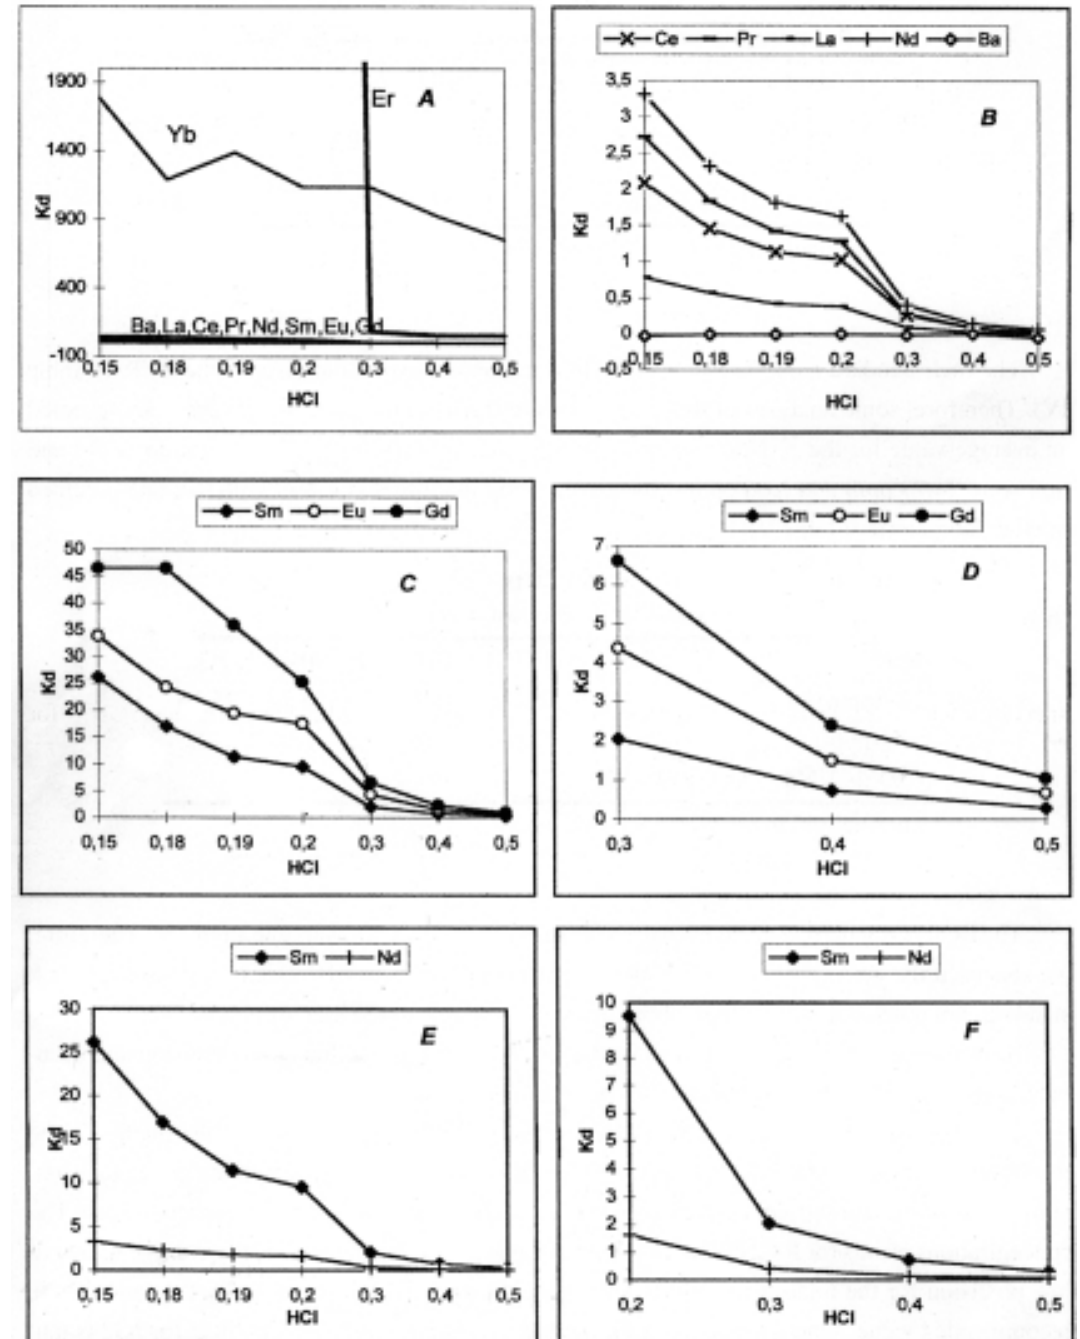
Fig. 4 – Determination of lanthanides partition coefficients.